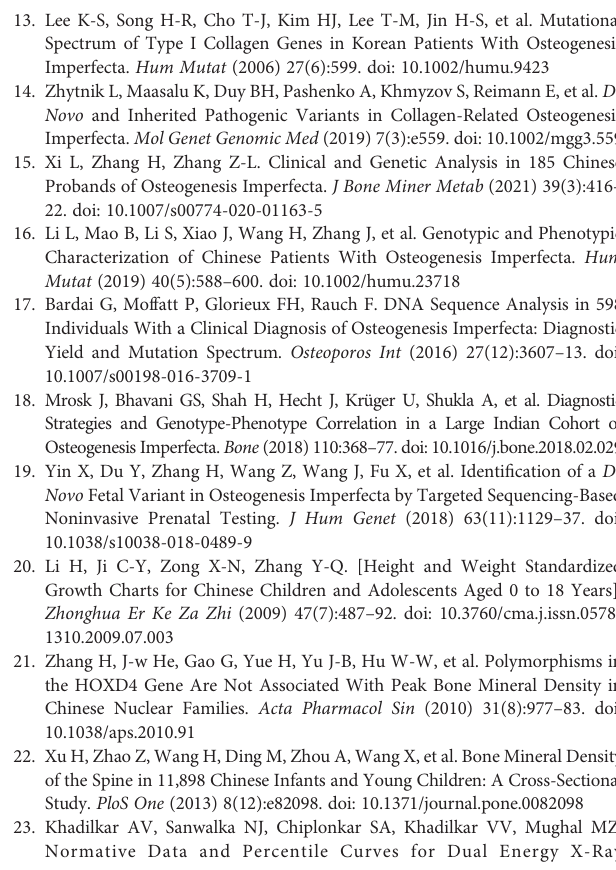
Supplementary Table 3 | Clinical characteristics of De novo